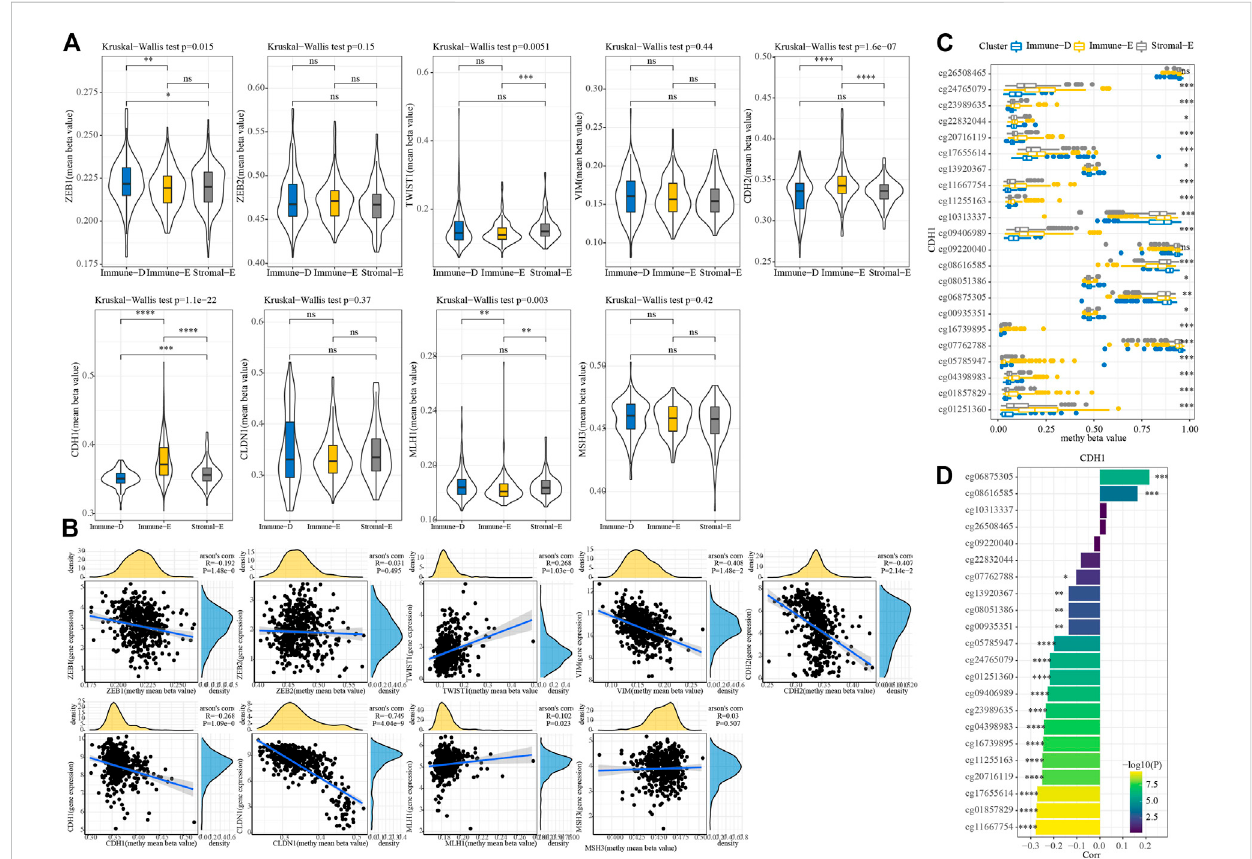
FIGURE 6 Methylation analysis of genes among the three molecular subtypes. (A) 450K beta value differences for nine genes among the three molecular subtypes. (B) Correlation analysis between 450K beta values and gene expression. (C) Distributions of beta in the cg probe site in CDH1 among the three molecular subtypes. (D) Correlation analysis between 450K beta values of CDH1 and CDH1 expression. * p < 0.05; ** p < 0.01; *** p < 0.001; **** p < 0.0001; ns: no signi fi